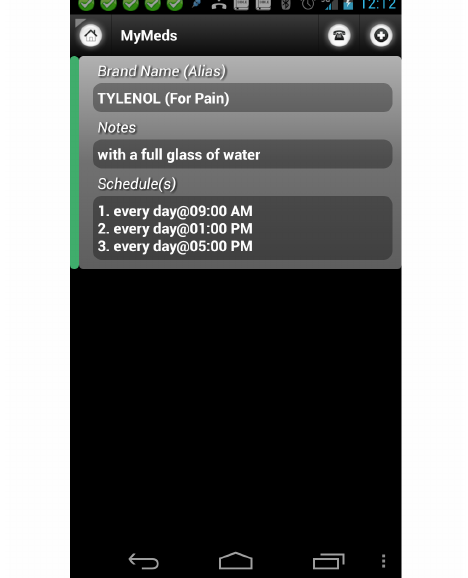
Figure 3. MyMed app with 650 mg Tylenol scheduled every 4